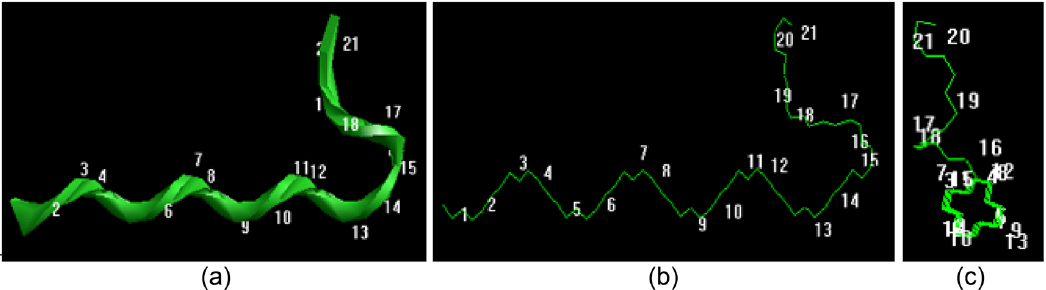
Figure 4: Endothelin, ET - I; ( a and b ) back - bone models ( no S – S bonds ) ; ( c ) a cavity - like loop formed between AA 1 – 15 where in AA 16 – 21 are not participating in the loop formation ( all structures are at minimum energy conformations MEC, optimized geometry